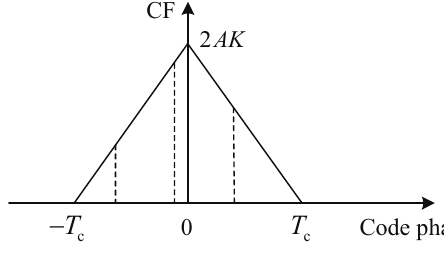
Figure 1. Model of correlation